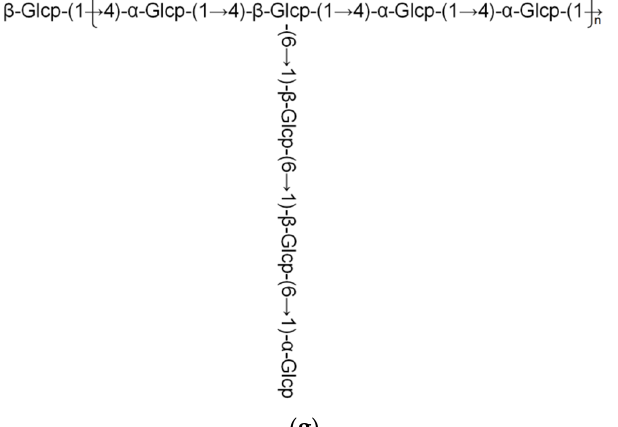
Figure 5. 1 H NMR ( a ), 13 C NMR ( b ), 1 H- 1 H COSY ( c ), HSQC ( d ), HMBC spectra ( e ), 1 H- 1 H NOESY ( f ), and predicted structure of OFP ( g ).